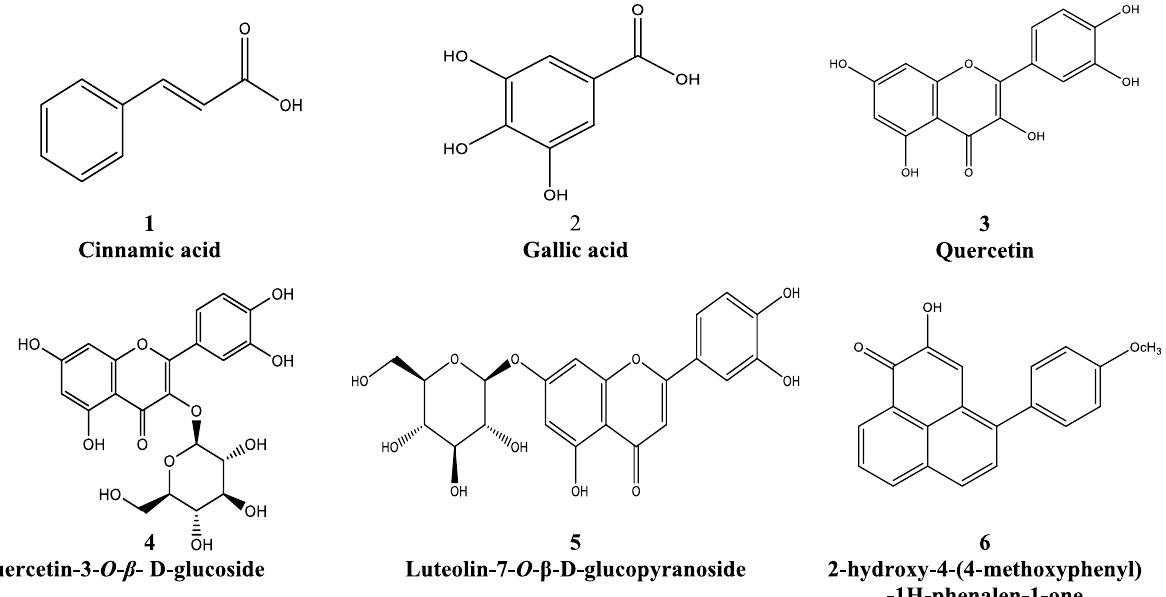
Figure 1. Six isolated compounds two phenolic acids, one phenylphenalenone and three